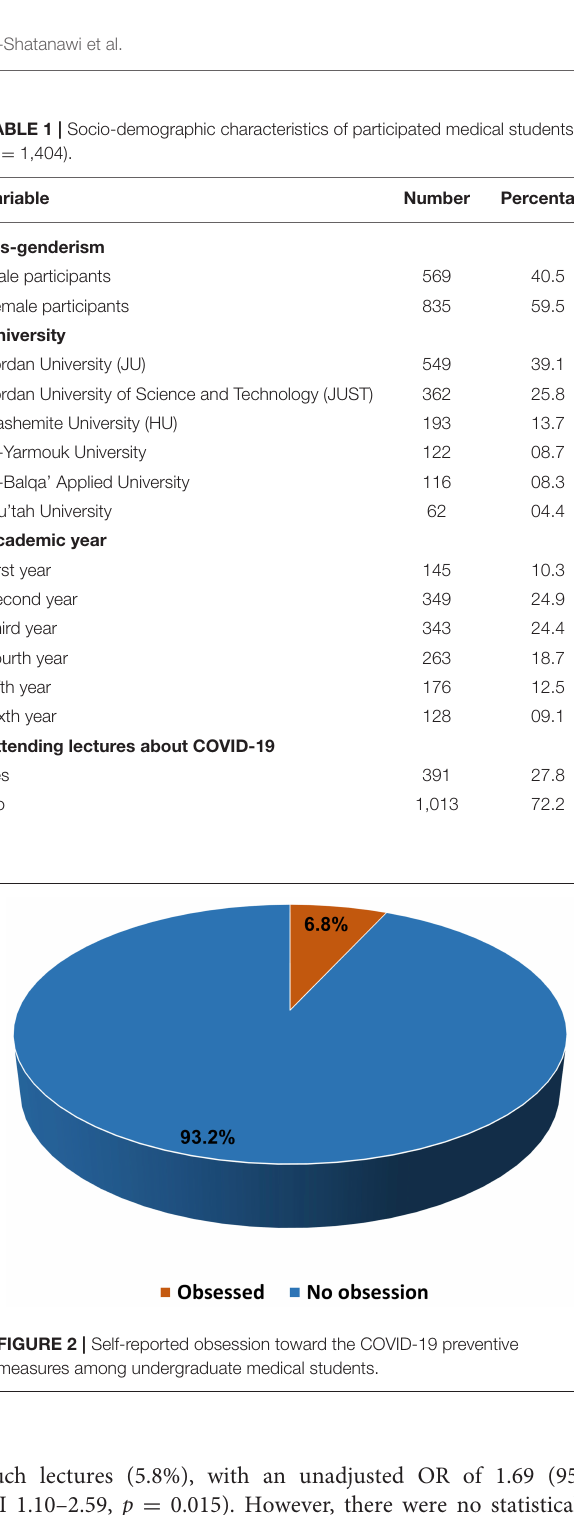
medical students who self-reported obsession toward COVID- 19 preventive measures and those who did not ( Table 4 ). A Levene’s test verified the equality of variances in the samples (homogeneity of variances) with a p > 0.05 for each scale. The students who had high levels of adapted precautionary measures toward COVID-19 (M = 33.414, SD = 5.95.57) were significantly more obsessed with preventive measures than those with low levels of precautionary measures (M = 29.816, SD = 6.10)